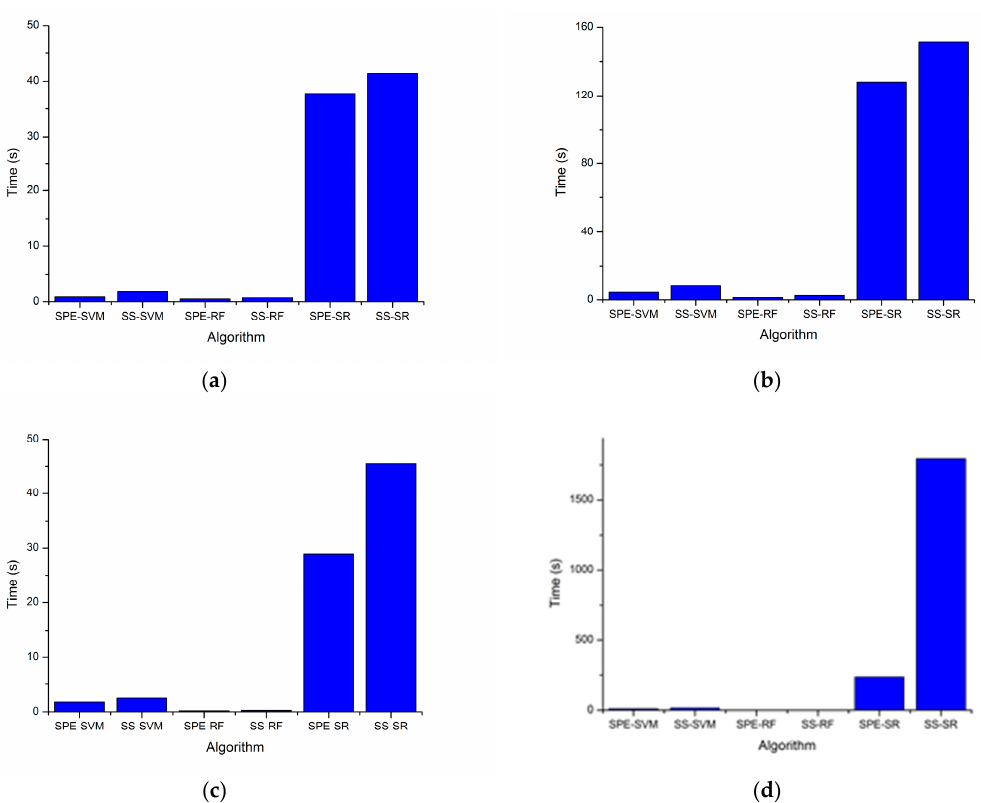
Figure 11. Computation time of different algorithms: ( a ) Hyperion dataset 1; ( b ) Hyperion dataset 2; ( c ) University of Pavia; and ( d ) Pavia center.